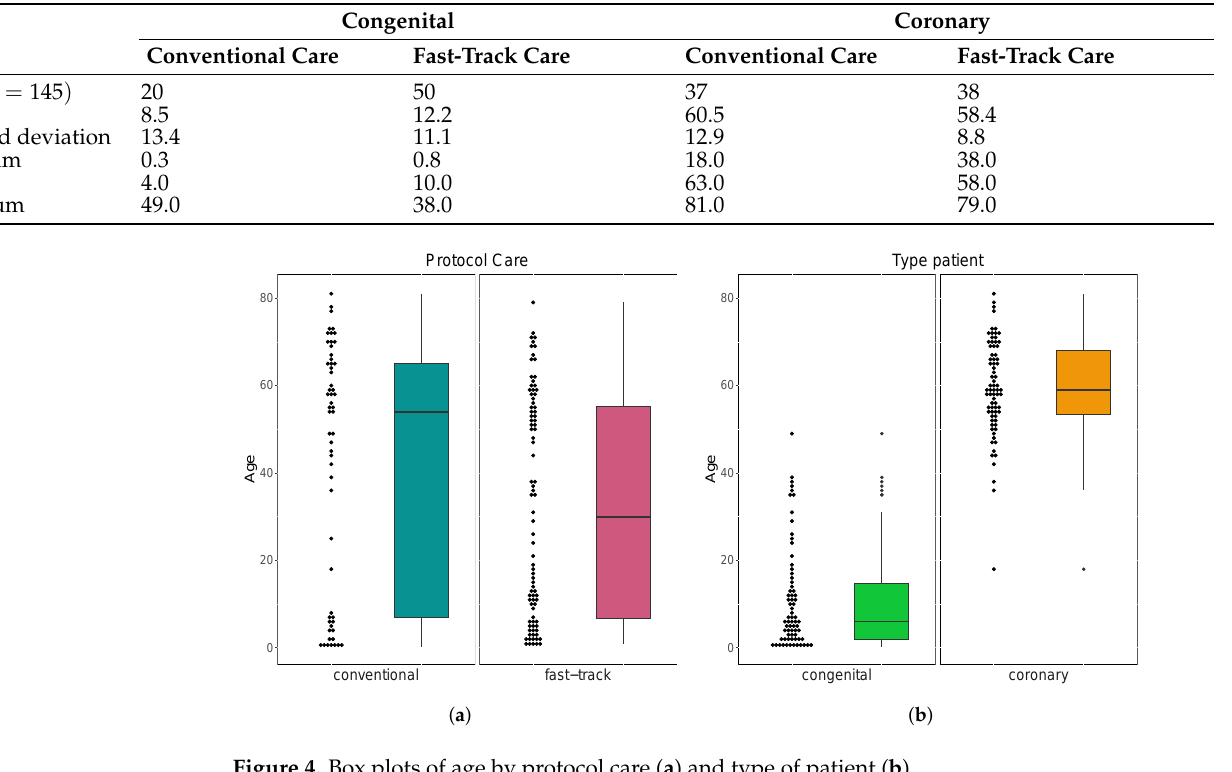
Table 1. Descriptive measures for the ages (in years) of patients with congenital and coronary heart disease followed up in both protocols.